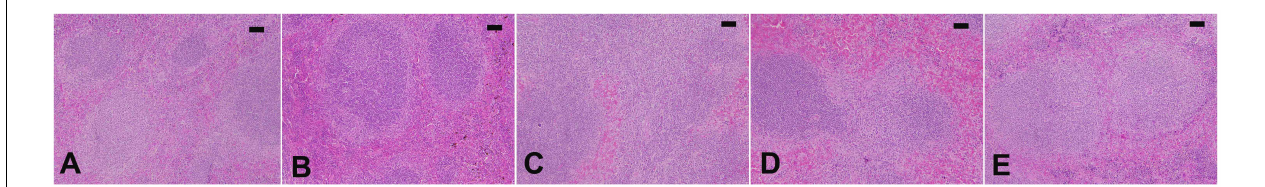
FIGURE 9 | Spleen histology of mice. Normal structure of control spleen (A) and ELE-treated (B) mice. (C) Infected spleen of mice with dilated and fused white and red pulps and increased apoptotic bodies. (D) ELE-treated infected spleen with improved structure. (E) Drug-treated spleen with improved structure. Scale bar = 50 µ m.